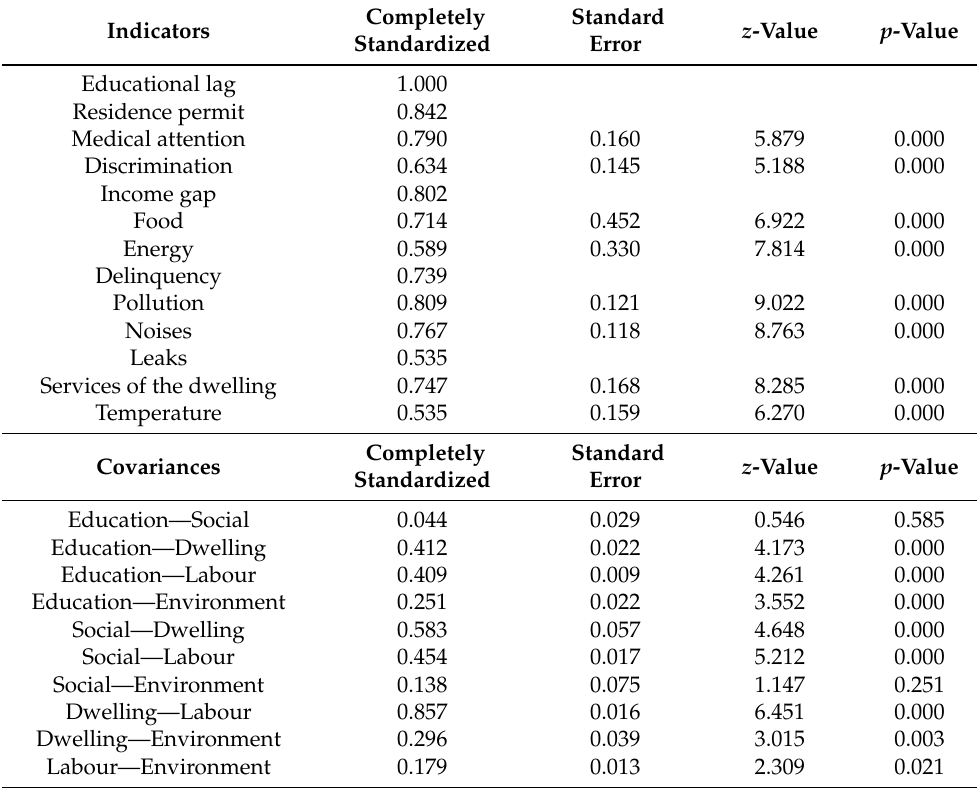
Table 3. Results of the indicators and covariances of the measurement model. Indicators